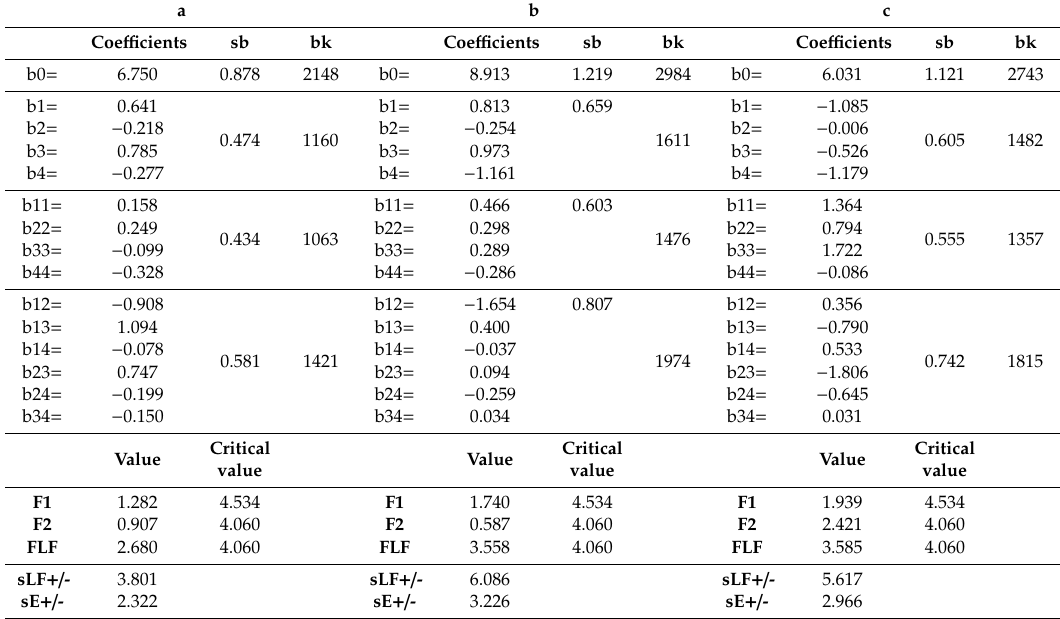
Table 2. Values of regression coe ffi cients of mathematical model for (a) samples measured immediately after plasma surface treatment, (b) samples of polar component measured immediately after plasma surface treatment, and (c) samples measured after 5 h after plasma surface